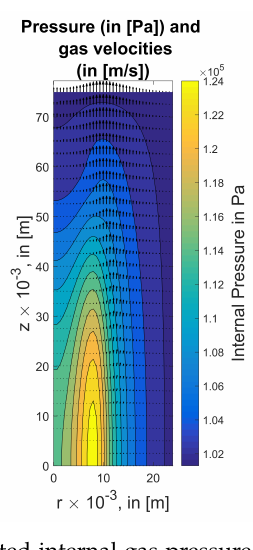
Figure 9. Internal gas pressure and axial and radial gas velocities—base case with AR = 3. The top of the wood log is at z = 75 mm (AR = 3), and the initial lateral surface of the wood log is at r = 25 mm.